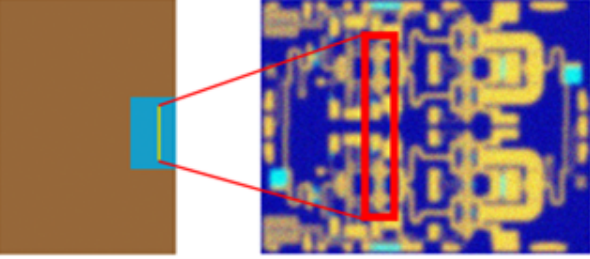
FIGURE 10. Graphic Schematization of the MMIC FET channels, whose transverse length is 2 mm.